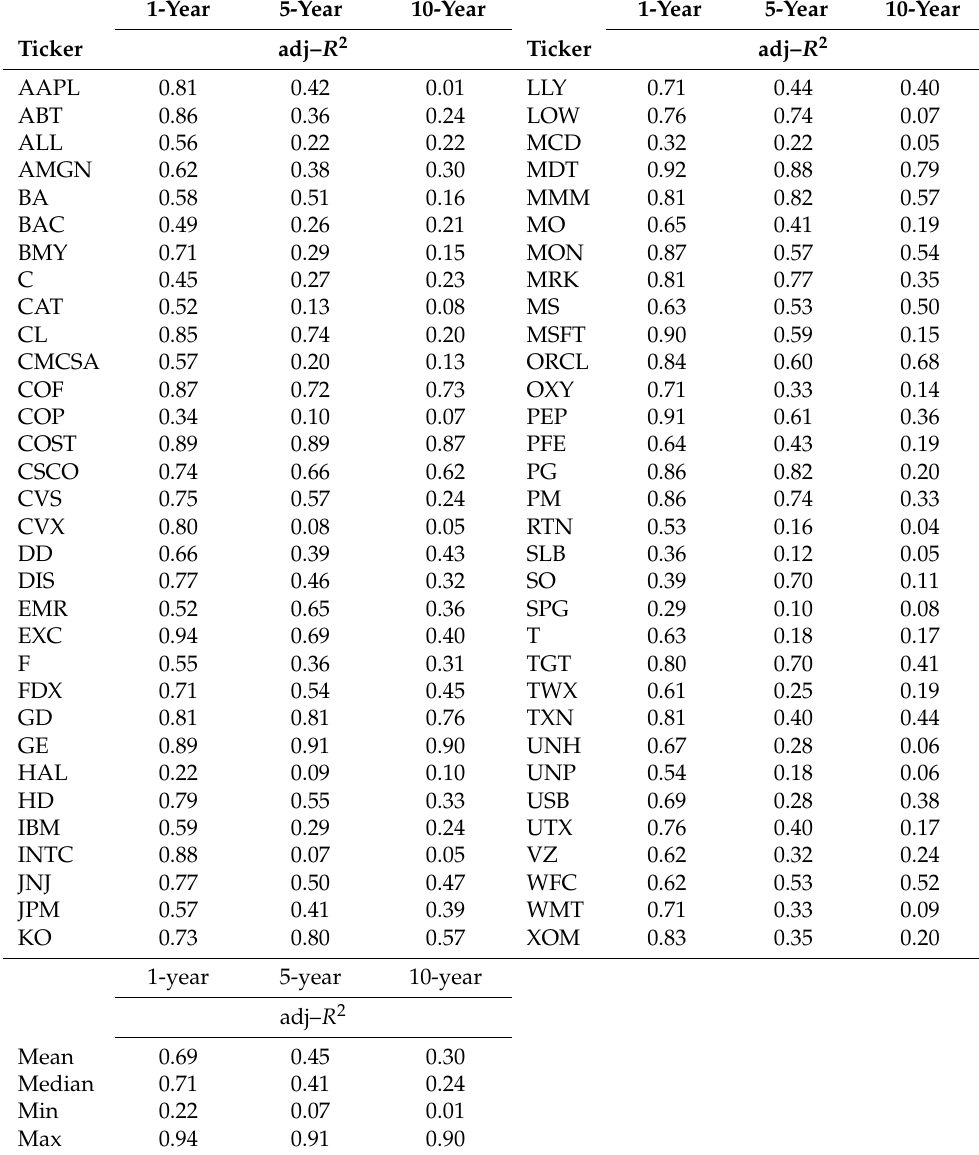
Table 10. Adjusted R 2 s of the firm-specific time-series regressions in (13) (short-term adjustments). As shown by both the mean- and median-adjusted R 2 , the explanatory power of the variables, which should affect credit spread changes as predicted by structural models, diminishes with the maturity of the